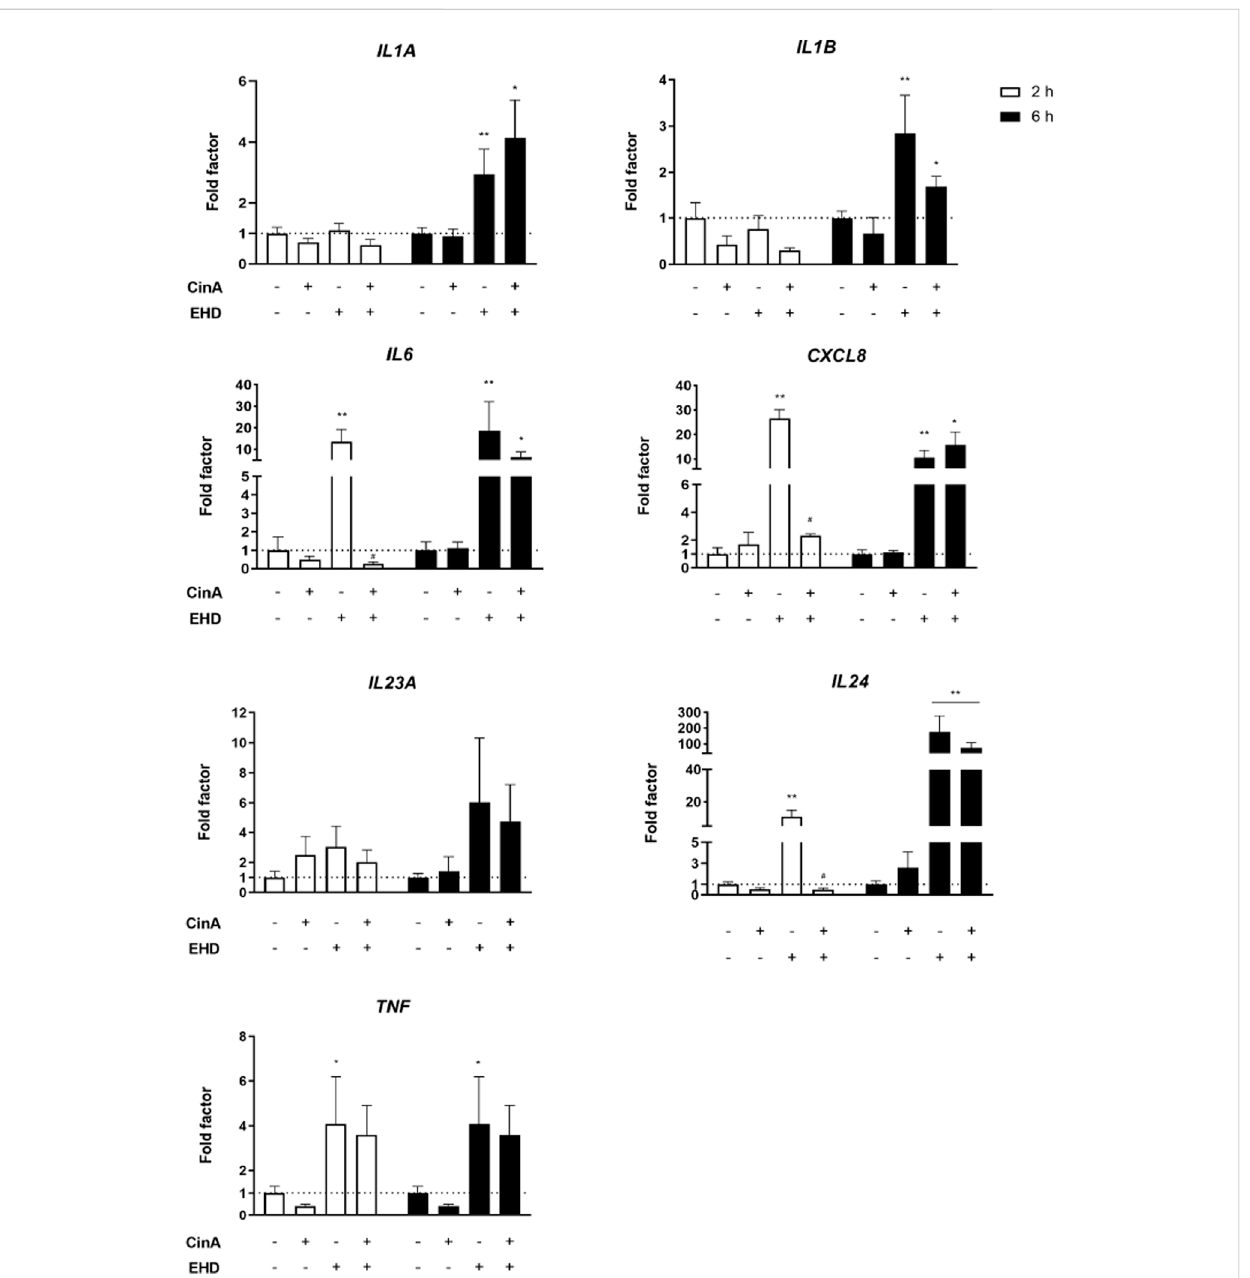
FIGURE 2 EHD induces an in fl ammatory response in KERTr cells . KERTr cells were treated for 2 and 6 h with CinA (100 μ M), EHD (10 μ M), a